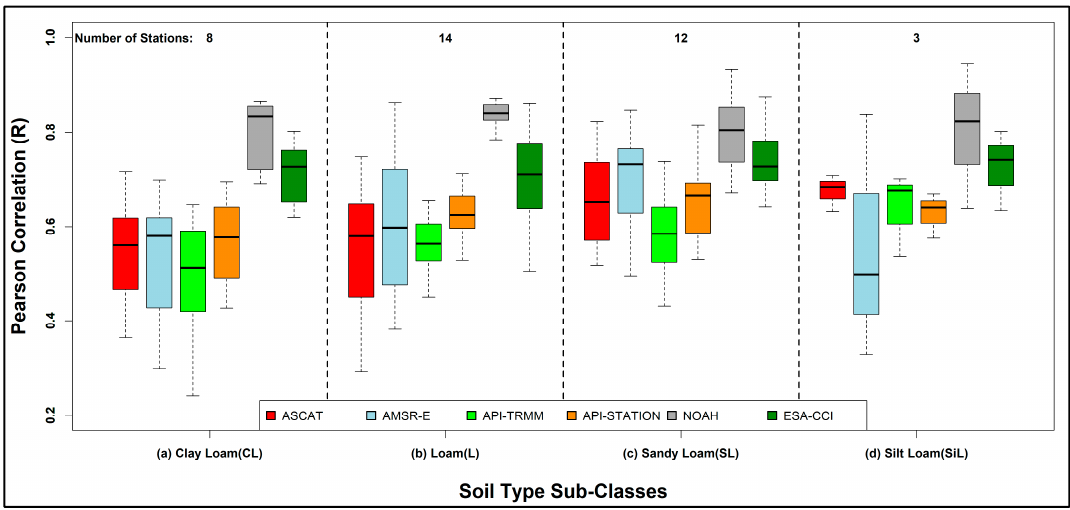
Figure 12. Correlations of soil moisture products under soil type sub-classes